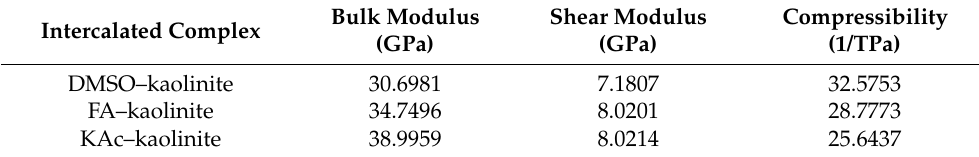
Table 3. The calculated elastic properties of the kaolinite intercalated complex. Intercalated